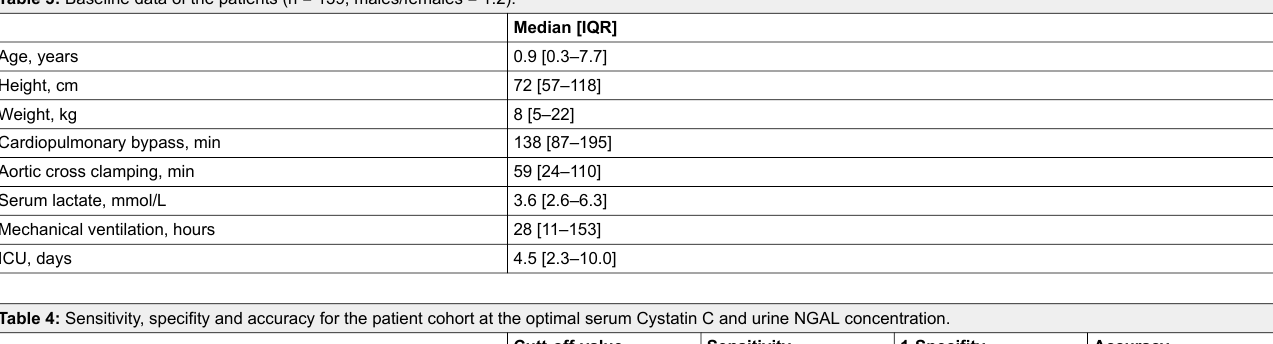
Table 3: Baseline data of the patients (n = 139; males/females = 1.2).